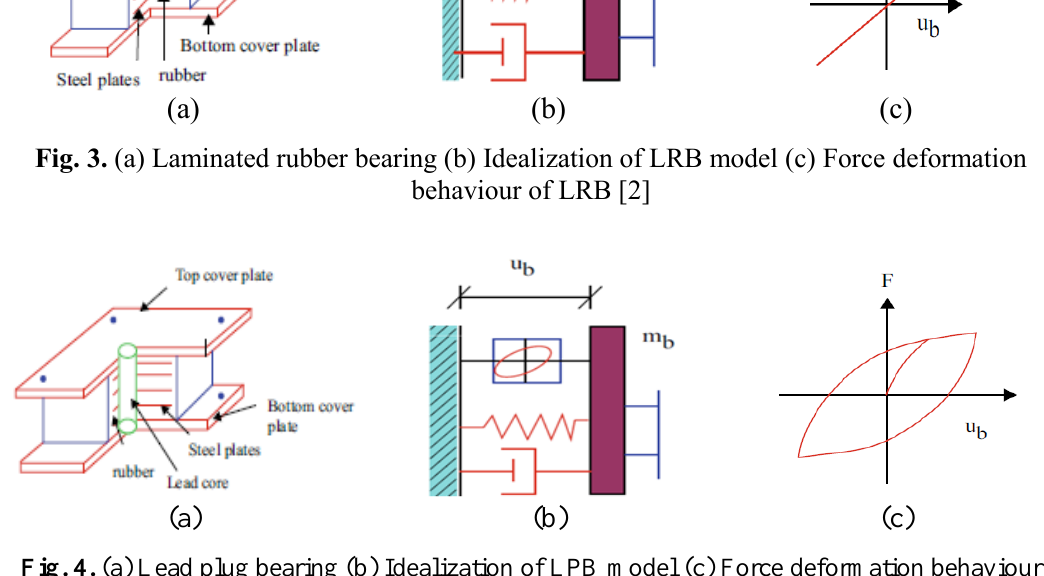
Fig. 4. (a) Lead plug bearing (b) Idealization of LPB model (c) Force deformation behaviour of LPB